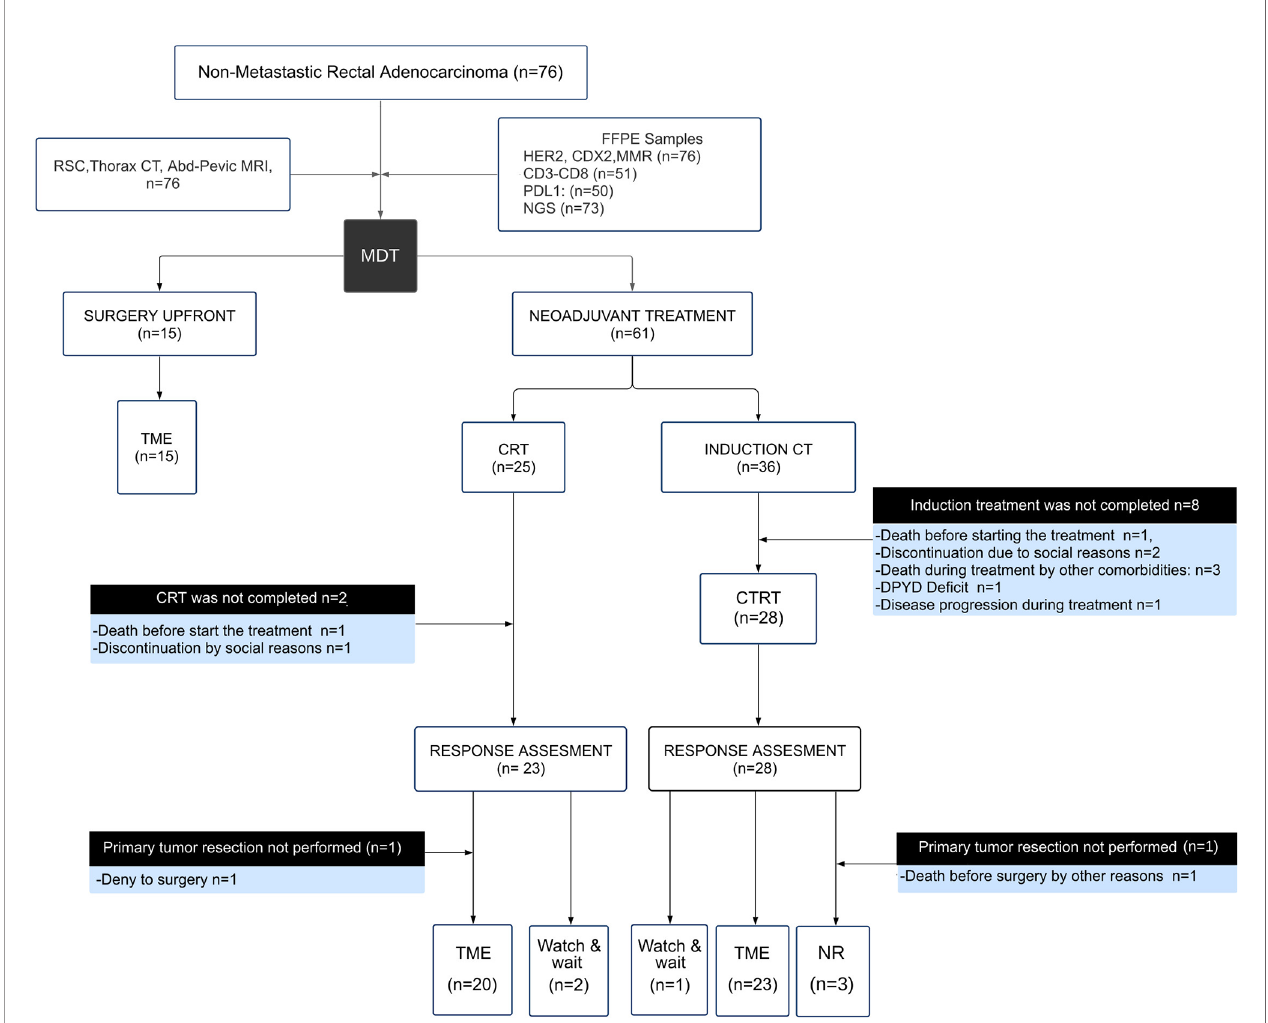
FIGURE 1 | Description of the study design and participants recruited by the multidisciplinary team (MDT). Flow chart showing the composition of the cohort, outcomes and results. Response assessment to neoadjuvant treatment (CRT) was determined in 49 patients as indicated at the bottom of the fl ow chart, including 43 total mesorectal excisions (TME), 3 watch and wait, and 3 non-resectable (NR)